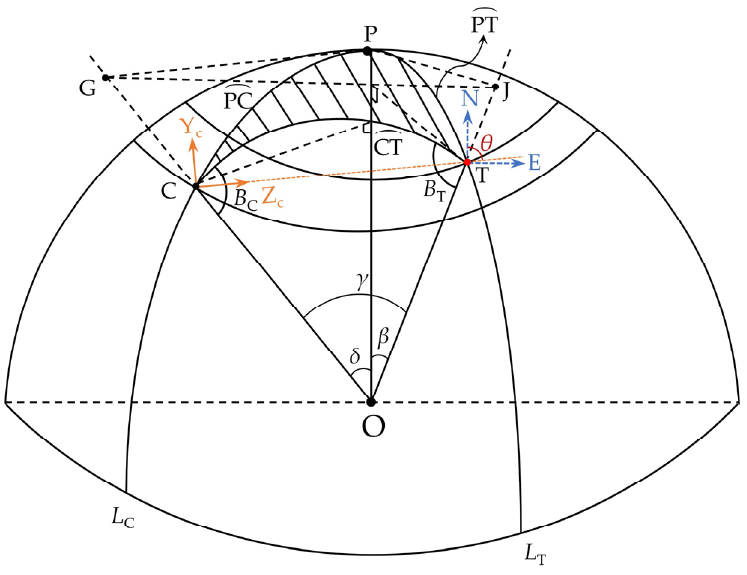
Figure 4. Spatial geometry for determining the yaw angles θ with GNSS.